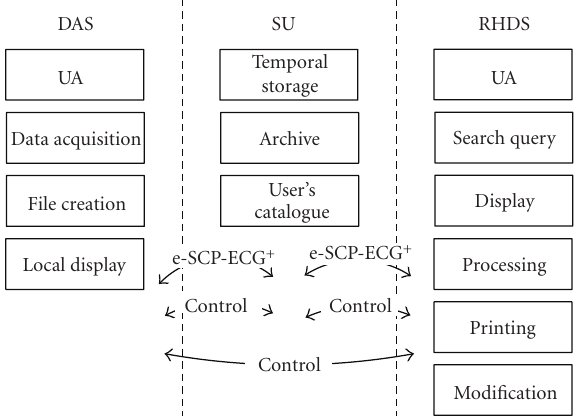
Figure 11: Applications flow